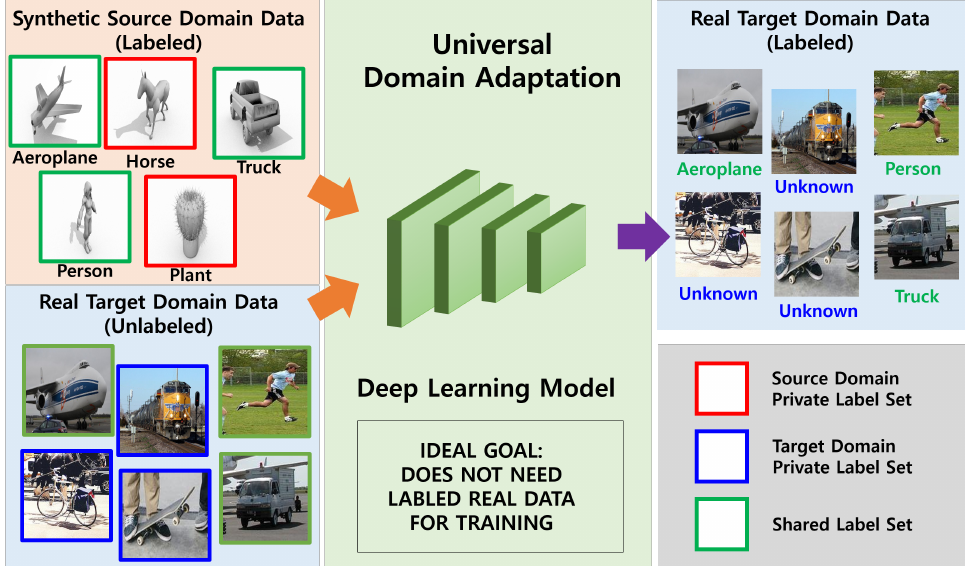
Figure 1. In ideal circumstances, universal domain adaptation should apply the knowledge learned from synthesized source domain data to the real target domain. Therefore, I focus on leveraging synthetic source domain data to reduce labeling costs by